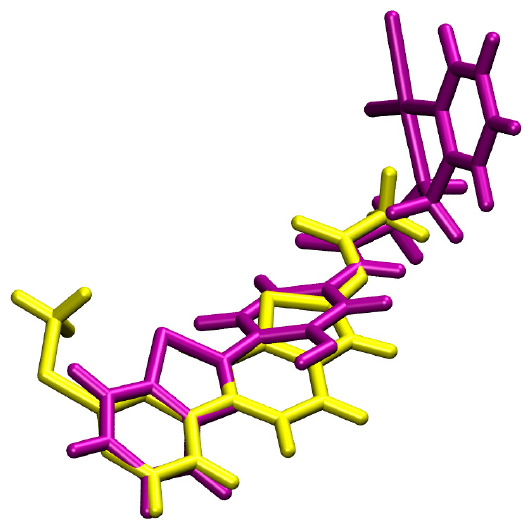
Overlapping of the selected pose (purple) and the PI3K active ligand ( N -(6-[2-(methylsulfanyl)pyrimidin-4-yl]-1,3-benzothiazol-2-yl) acetamide) (yellow).